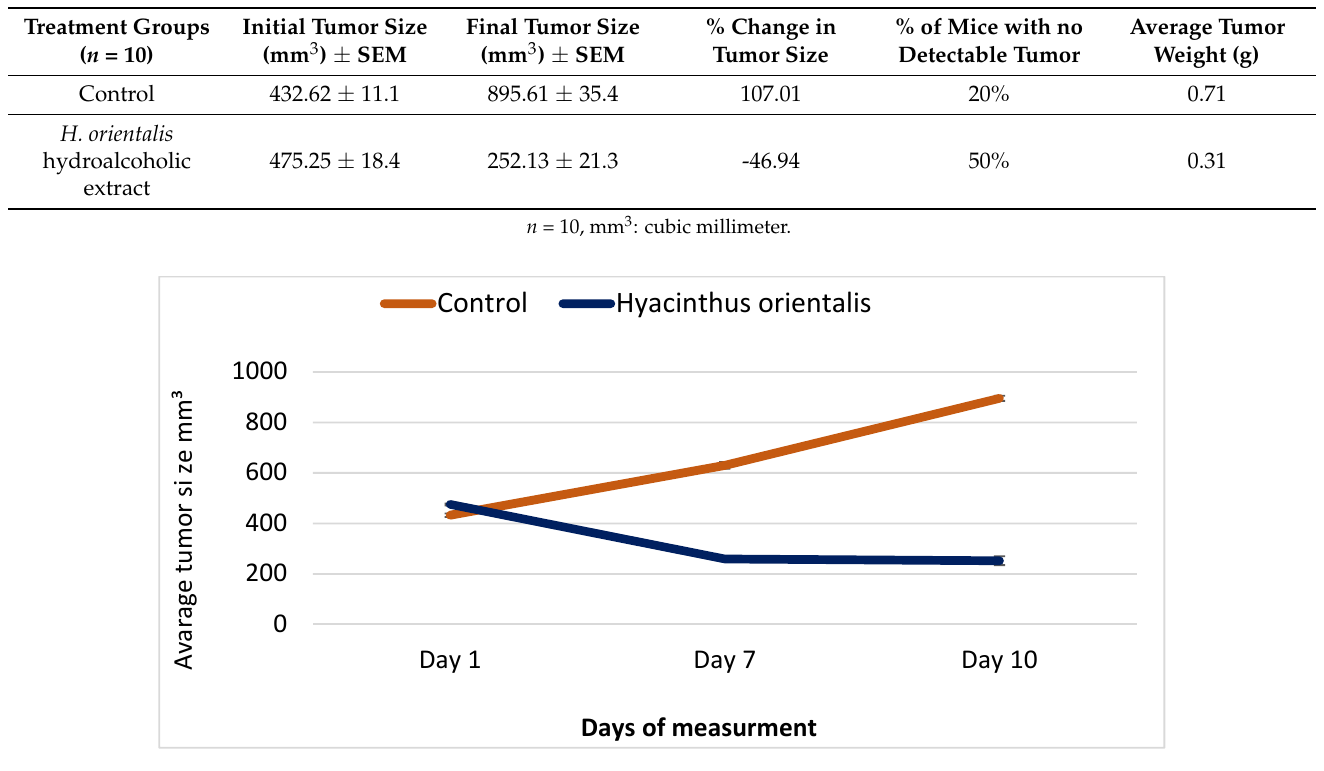
Figure 8. A plot demonstrated the changes in average tumor size (mm³) vs. time in (days) of treatment with H. orientalis L. hydroalcoholic extract in EMT6/P cell line.